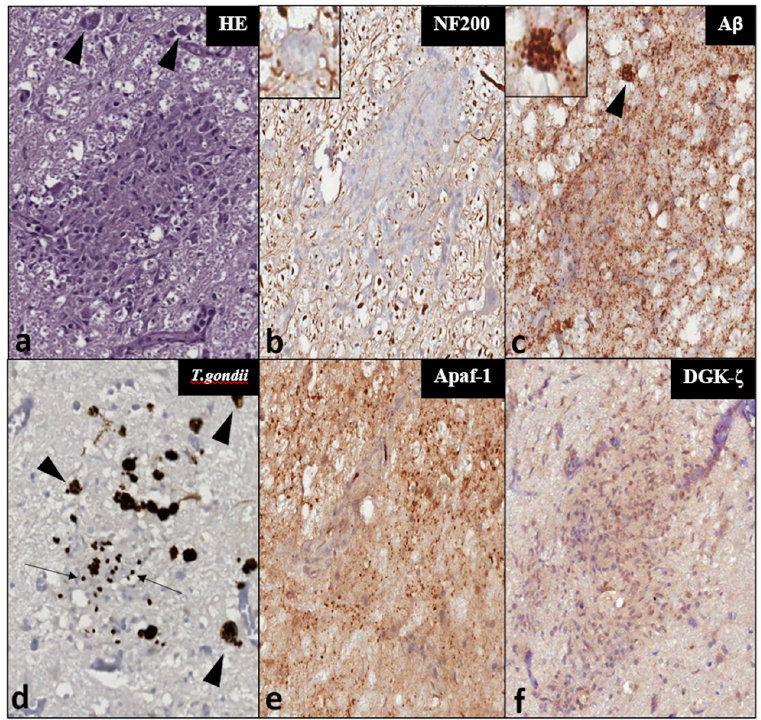
Fig 3. Comparison between histochemical and IHC staining results for a glial node surrounding T . gondii cysts (arrowheads) in the IC of ID142—Magnification: 200x. Insets display detail of cysts at a magnification of 400x. (a) HE-stain. (b) NF200-IR within the glial node tissue (c) A β -IR which also localizes to the T . gondii cysts (inset); (d) T . gondii cysts and zoites recognized by a specific anti- T . gondii antibody; (e) Apaf-1-IR appears attenuated within the cell-rich microglial nodule in comparison to the granular IR and high background of the surrounding neuropil; (f) DGK- z -IR is mildly stronger within the glial cells of the parasitic nodule compared to the surrounding neuropil.